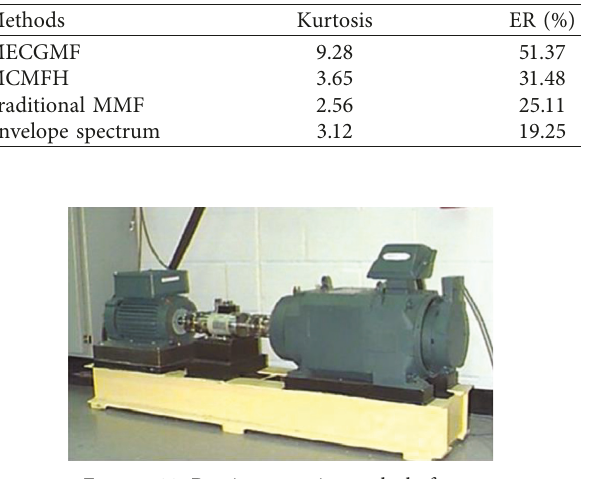
Table 2: Comparison results of the MECGMF, MCMFH, tradi- tional MMF, and envelope spectrum.